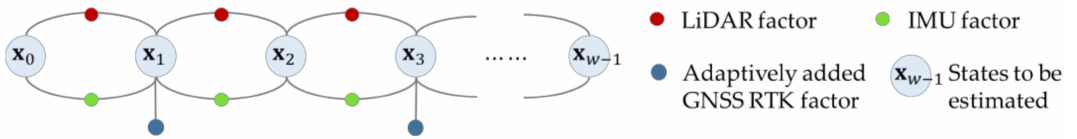
Figure 3. The factor graph of the adaptive GNSS/LiDAR/IMU fusion procedure. The states to be estimated are the global position and the relative rotation of the vehicle. The LiDAR factor and the IMU factor are relative constraints of the 6D state. The GNSS factor is adaptively added depending on the GNSS-RTK availability assessment to provide absolute constrain of the position